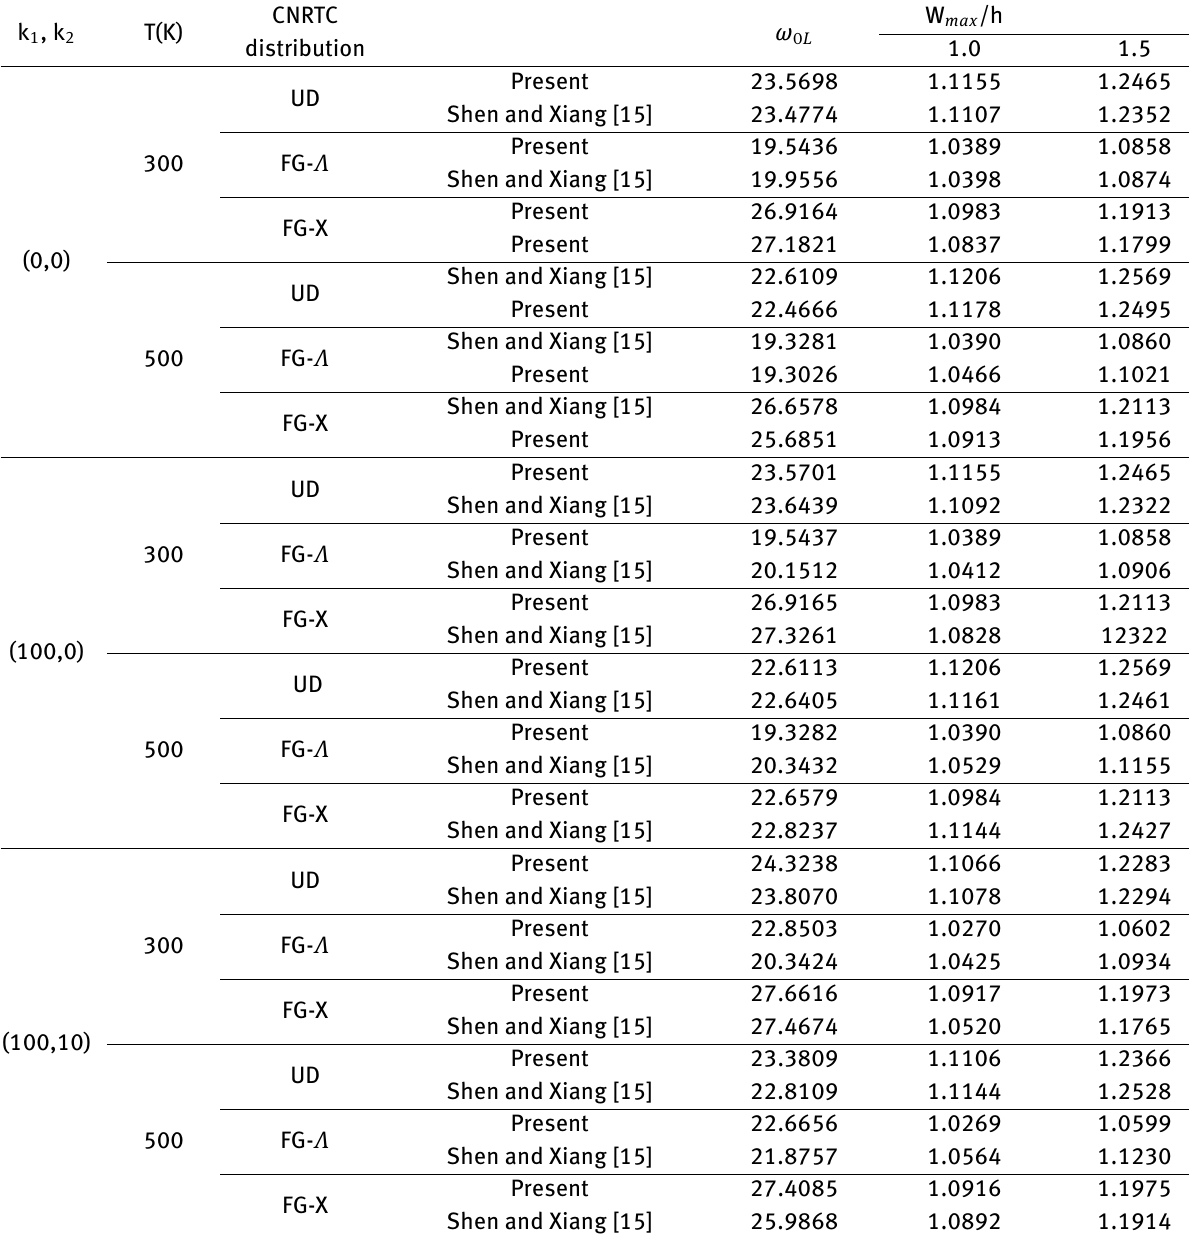
Table 5: Validation table for nonlinear to linear frequency ration ω NL / ω L for CNTRC beam resting on elastic foundation in thermal